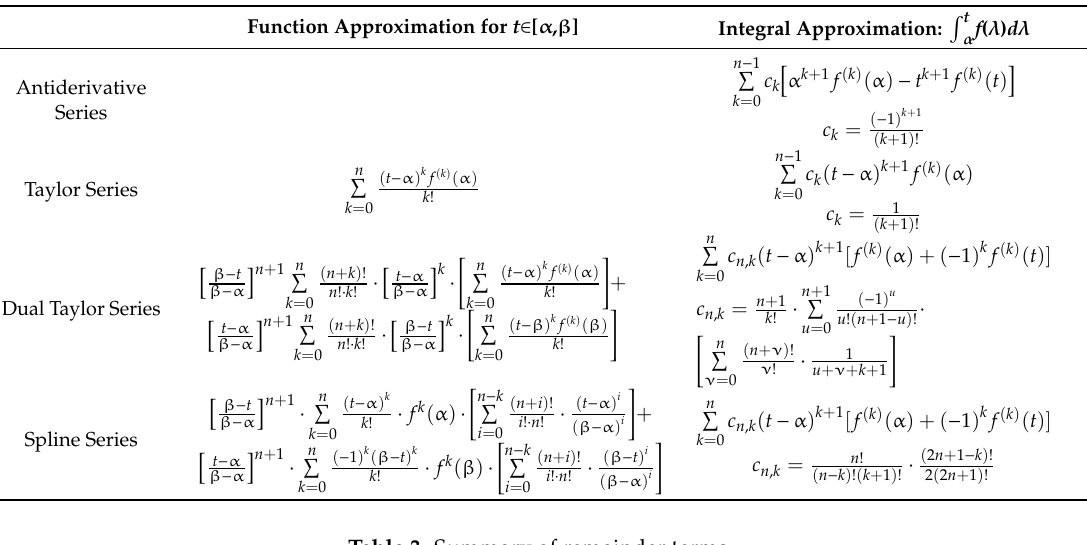
Table 3. Summary of remainder